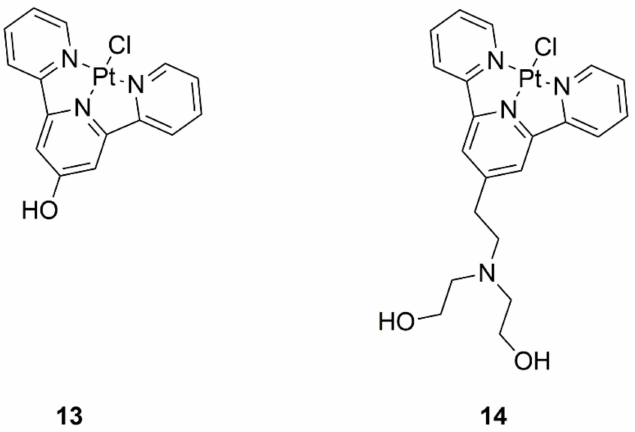
Figure 4. Structures of platinum(II) complexes with terpyridine derivatives exhibiting anticancer activity—( 13 ) complex with 2,6-bis(2-pyridyl)-4[1 H ]-pyridone and ( 14 ) 2,2 (cid:48) -((2-([2,2 (cid:48) ;6 (cid:48) ,2”-terpyridin]- 4 (cid:48) -yloxy)ethyl)azanediyl)bis-(ethan-1-ol).